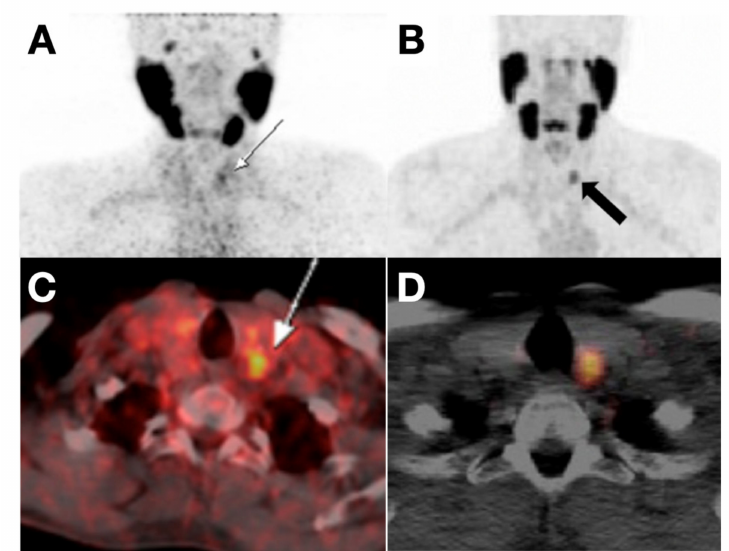
Figure 6. ( A , C ) PET and PET/CT fusion images showed slight [ 68 Ga]Ga-PSMA uptake in the thyroid nodule of a 62-year-old patient with prostate cancer. The thyroid nodule was validated as Hürthle cell angioinvasive FTC by post-thyroidectomy pathology. Reproduced with permission from [88] copyright 2016 Society of Nuclear Medicine and Molecular Imaging. ( B , D ) PET and PET/CT fusion image marked 68 Ga-PSMA uptake in the thyroid nodule of a 65-year-old man with metastatic prostate cancer. The thyroid nodule was regarded as TC proved by post-thyroidectomy pathology. Reproduced with permission from [91], copyright 2017 Wolters Kluwer Health Inc.